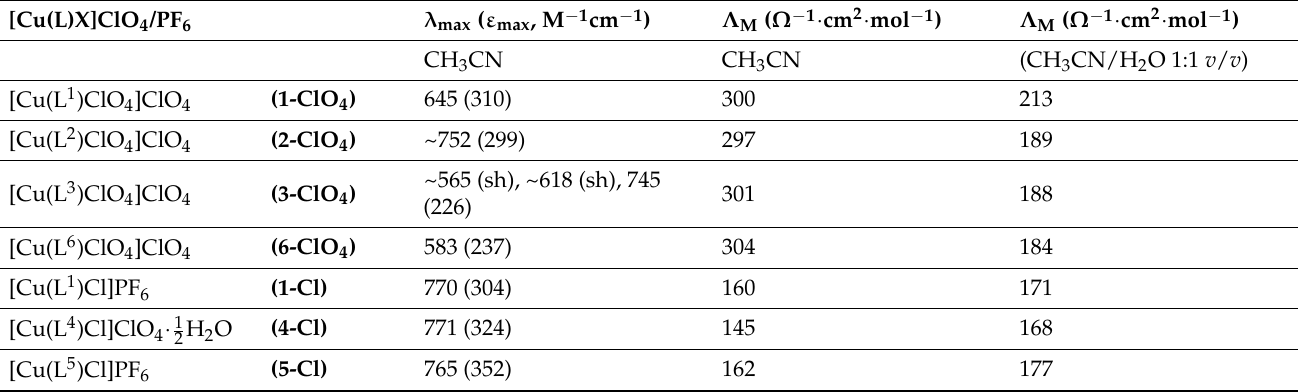
Table 1. Visible spectral and molar conductivity data for the chlorido and perchlorato Cu(II)-based piperazine pyridyl complexes, [Cu(L)X]ClO 4 /PF 6 in